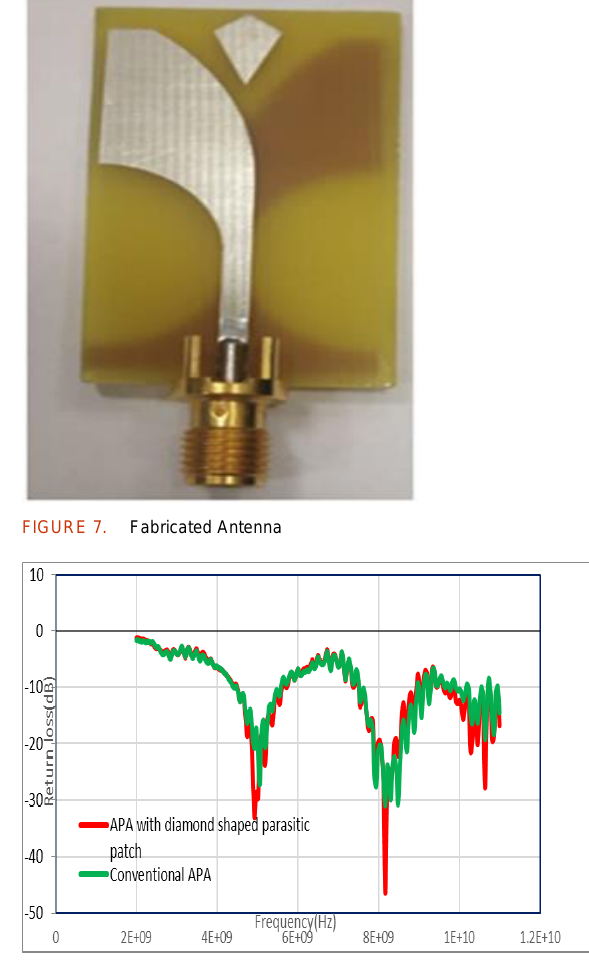
FIGURE 8. Reflection coefficient of fabricated